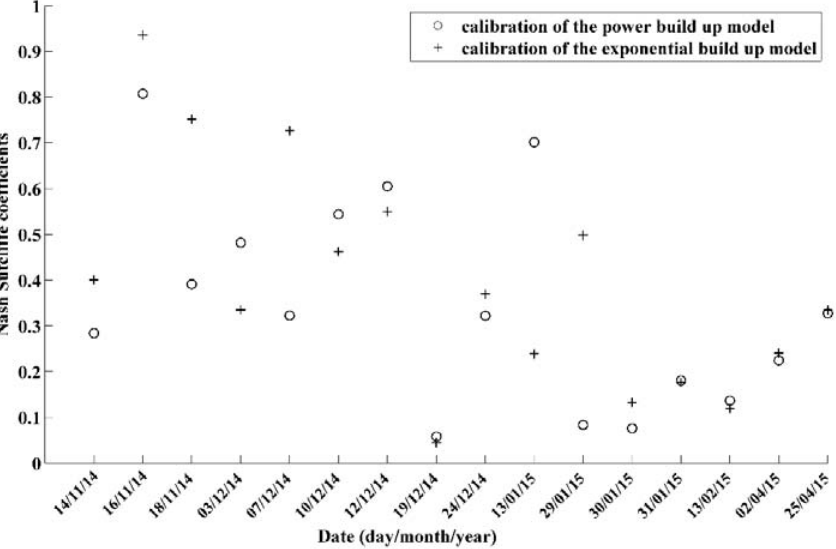
Figure 13. Comparison of the Nash–Sutcliffe coefficients calculated when calibrating the exponential build ‐ up and the power build ‐ up.